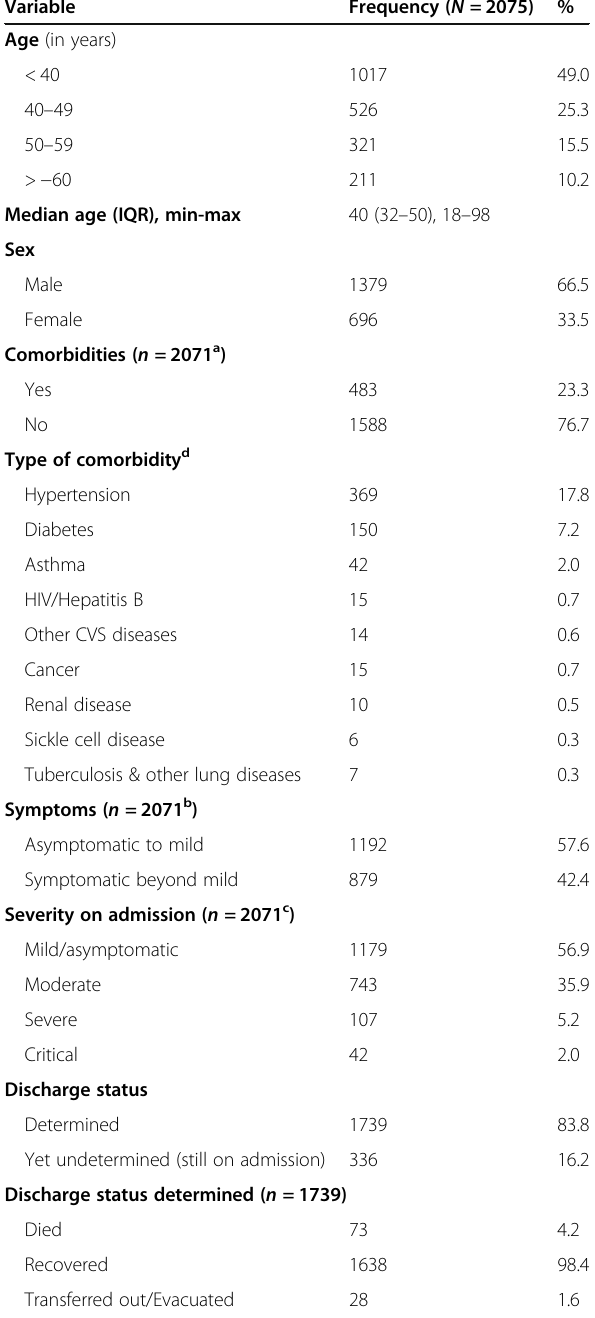
Table 1 Patient